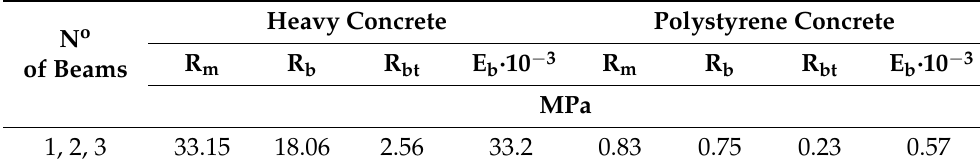
Table 4. Strength and deformative characteristics of concrete in experimental beams.